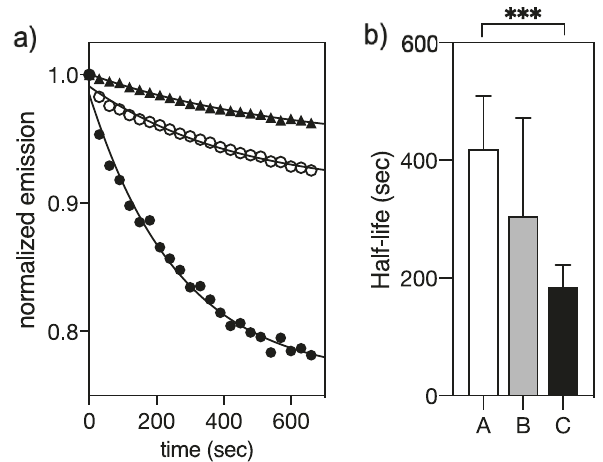
Fig. 4 Binding of α H-His 2 [Pd] to KRAS, and RAS-binding switching studied by fl uorescence anisotropy. a Normalized emission anisotropy at 559 nm of a 15 nM solution of α H-His 2 [Pd] with increasing concentrations of KRAS wt . The best fi t to a 1:1 binding model is also shown 43,44 ; b anisotropy values for: A, a saturated α H-His 2 [Pd]/KRAS complex; B, same solution after addition of 50 eq. of DEDTC; C, solution in B after addition of 50 eq. of cis -Cl 2 Pd(en). Data are mean ± SEM for experiments performed in technical triplicate and are representative of at least three biological replicates performed with independent preparations of recombinant KRAS wt . All experiments carried out at 25 °C. Data were subjected to a One-Way ANOVA statistical analysis, *** p < 0.001.